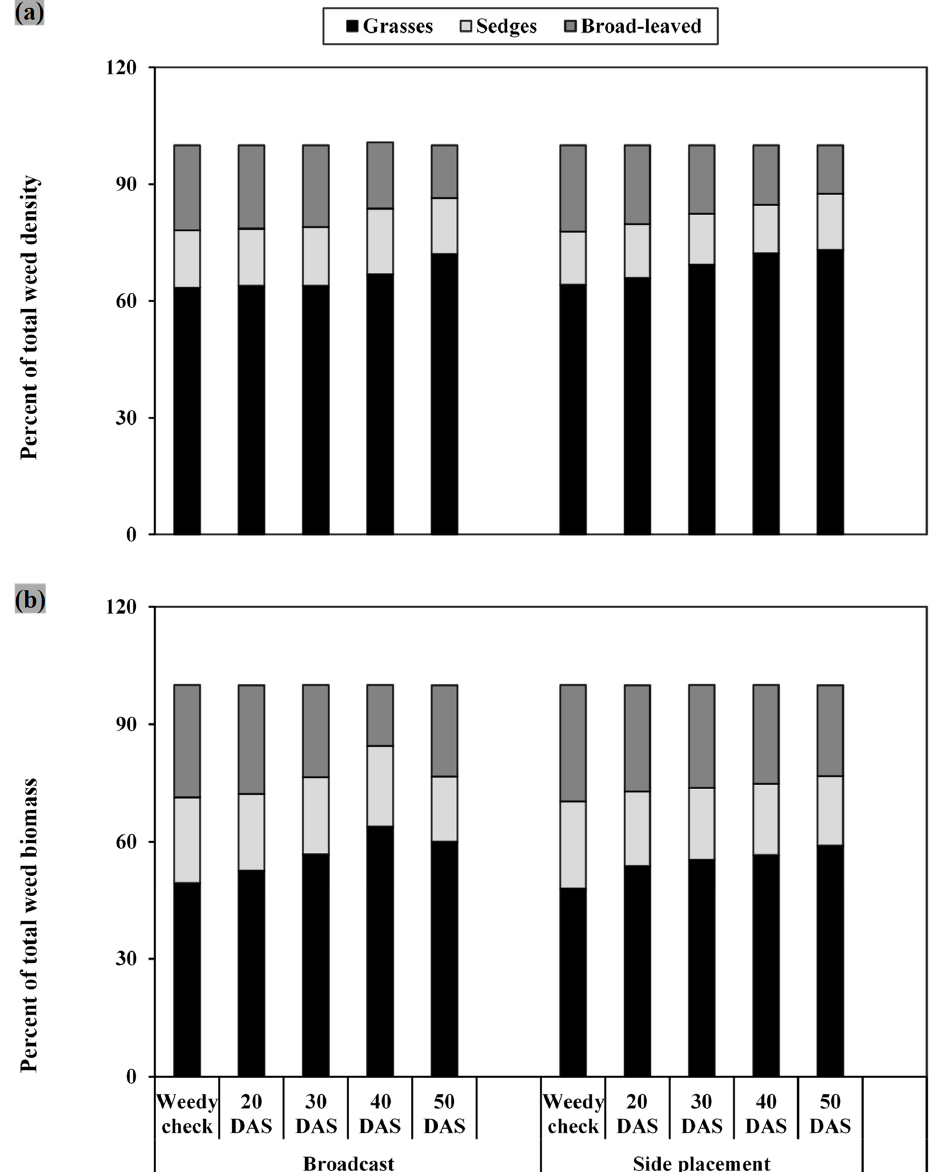
Figure 3. Relative proportion of different weed types (grasses, sedges and broad leaf weeds) on percentage basis in total ( a ) weed density and ( b ) weed dry biomass in direct-seeded rice under different fertilizer application methods. Units on x -axis remain same for both a and b figures, (2 years mean data and six replicates).